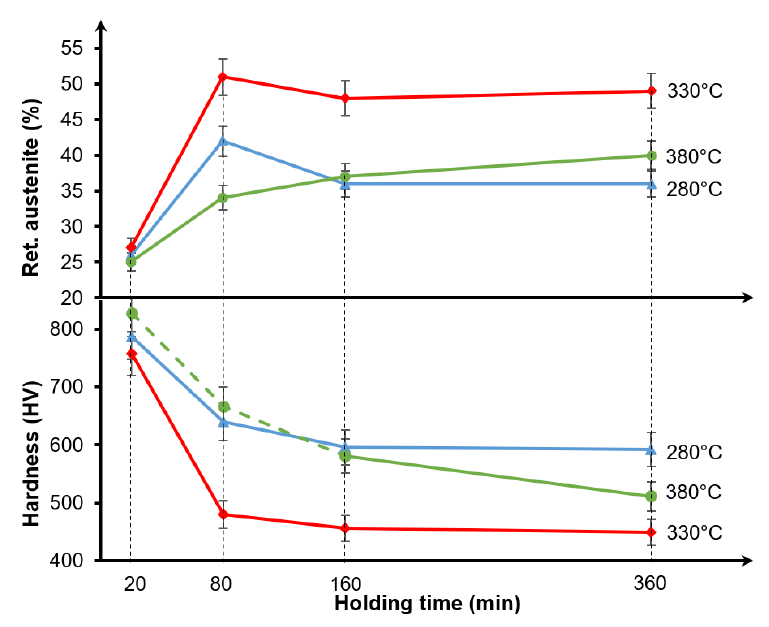
Figure 7. Volume fraction of retained austenite and Vickers Hardness (HV) as function of holding time at different transformation temperatures.